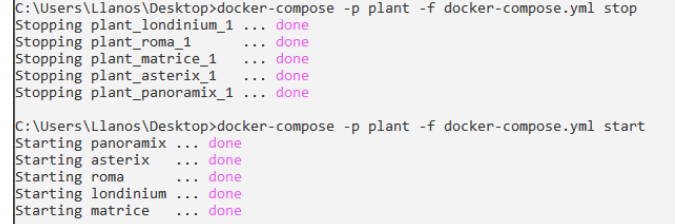
Figure 6. Starting/Stopping the Network of